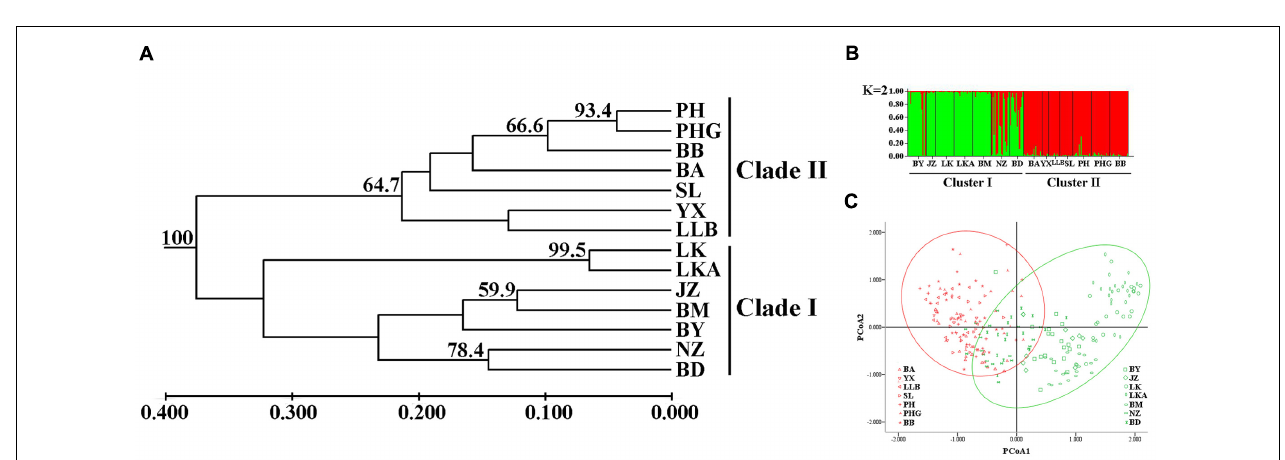
FIGURE 5 | Figure plot of geographical distance against genetic distance for 14 populations of C. segmentifida .